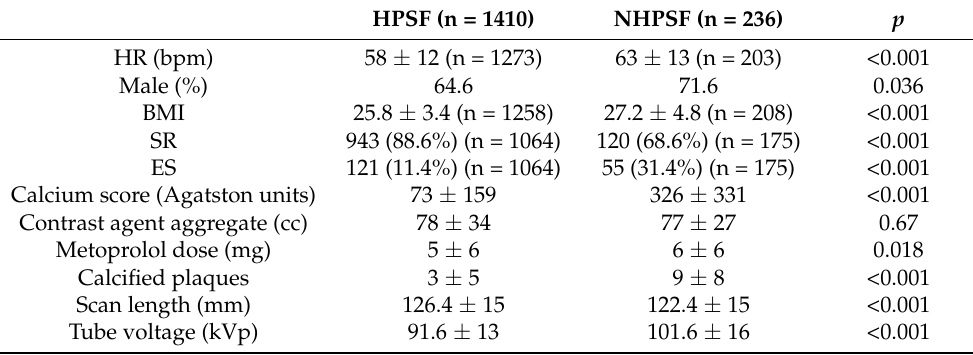
Table 1. Patient characteristics. HPSF: high-pitch spiral scan first; NHPSF: non high-pitch spiral scan first; HR: heart rate; SR: sinus rhythm; ES: extrasystoles; BMI: body mass index; bpm: beats per